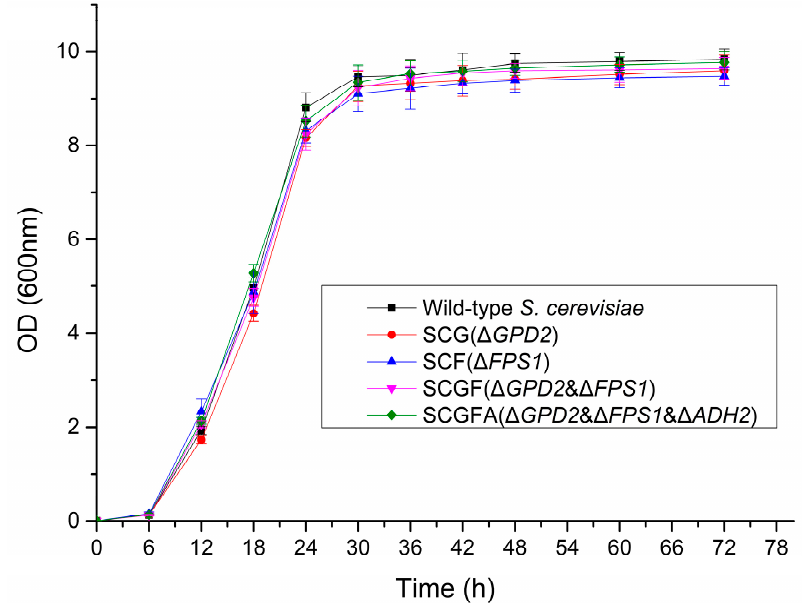
Figure 4. Effect of gene deletion on the growth curve of S. cerevisiae . SCG( Δ GPD2 ), SCF ( Δ FPS1 ), SCGF ( Δ GPD2 & Δ FPS1 ) and SCGFA ( Δ GPD2 & Δ FPS1 & Δ ADH2 ) represented S. cerevisiae mutants with GPD2 Δ , FPS1 Δ , GPD2 Δ FPS1 Δ , GPD2 Δ FPS1 Δ ADH2 Δ , respectively.